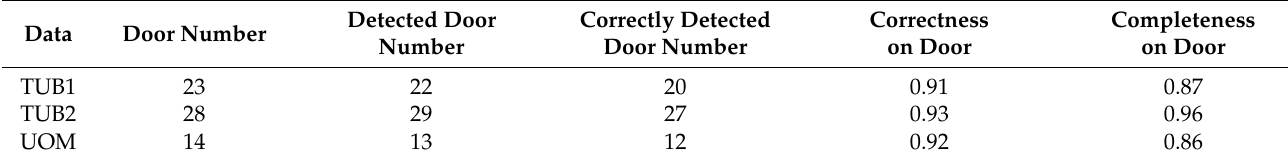
Table 5. Opening for benchmark